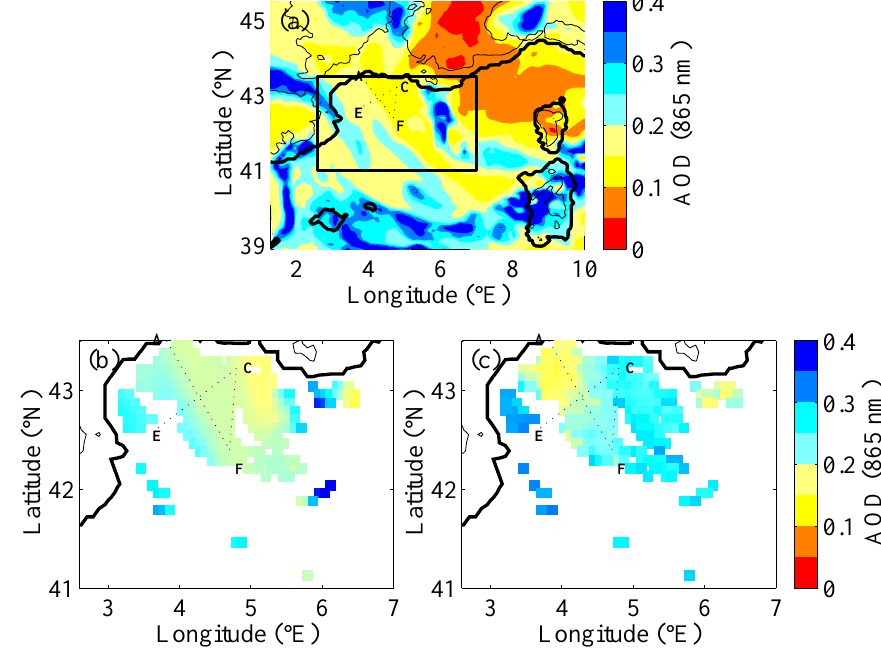
Fig. 8. Panel a: simulated aerosol optical depth (AOD) at 865 nm derived from CHIMERE simulation at 1200 UTC (domain 2). The rectangle indicates the zoomed area shown in pan- els (b) and (c); Panel b: simulated AOD at 865 nm at 1200 UTC over the Gulf of Lions with the cloud mask derived from the Sea-viewing Wide Field-of-view Sensor (SeaWIFS) observa- tions; Panel c: AOD at 865 nm derived from SeaWIFS measurements at 1132 UTC. The dotted line corresponds to the flight track of the ARAT carrying the water vapor lidar LEANDRE-2 on March 24, 1998 in the afternoon.